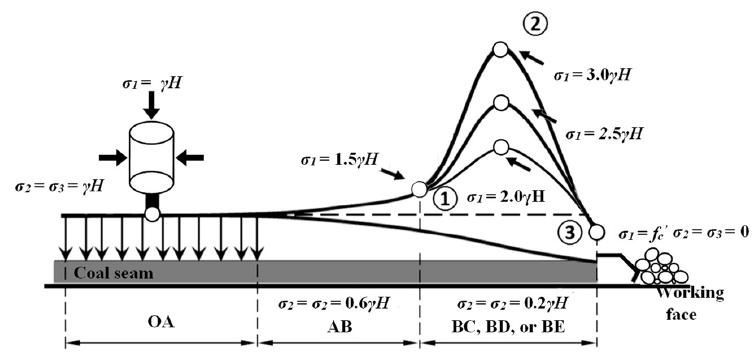
Figure 4. The stress state of coal mass in front of the working faces under three different mining layouts.